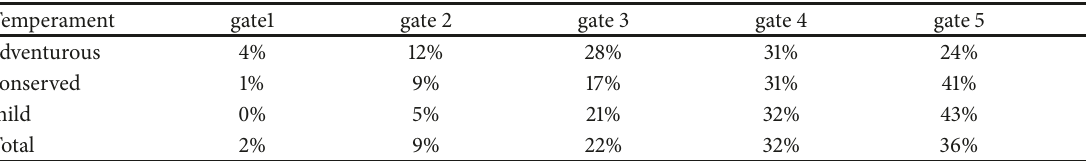
Table 2: Results of local route choice for different passengers.